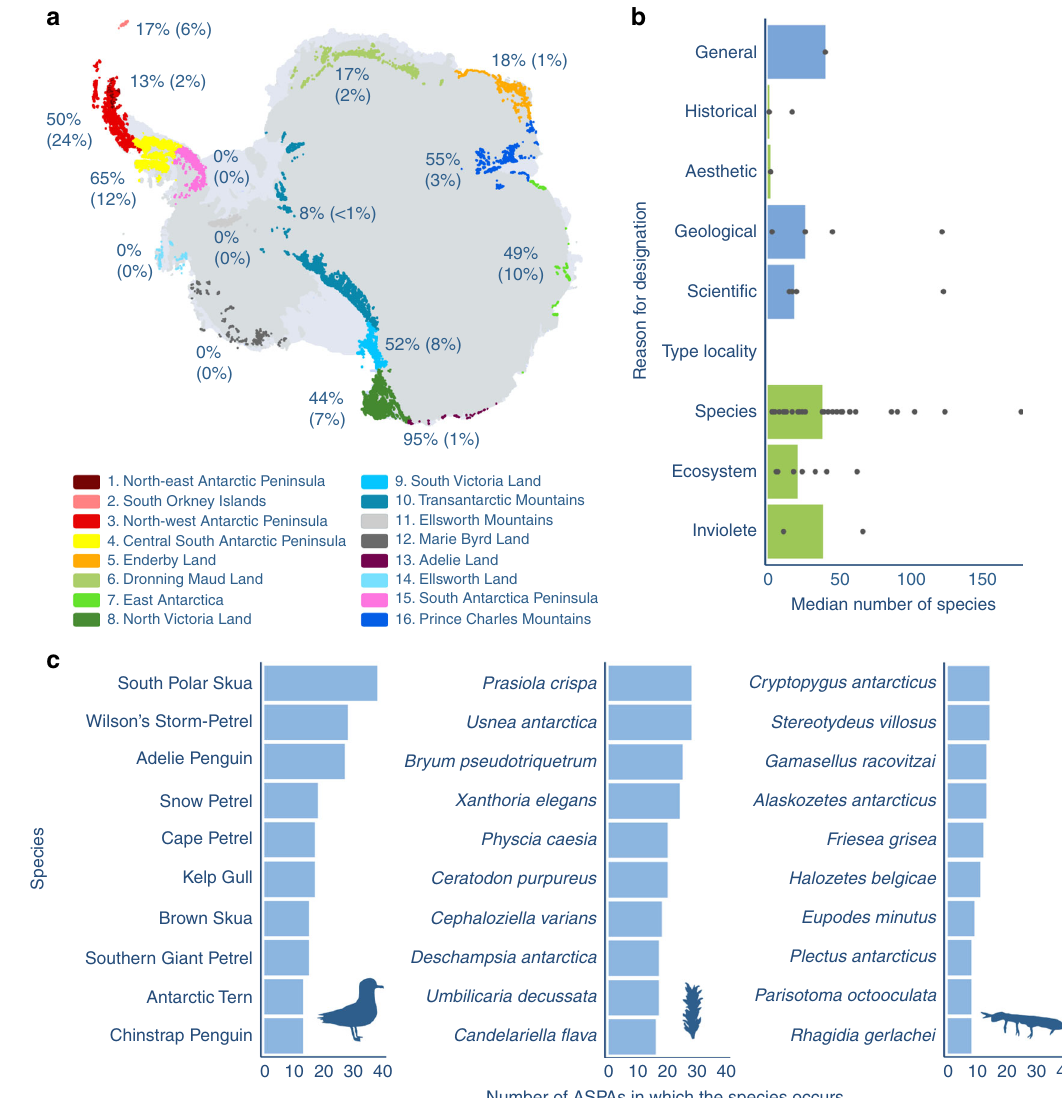
Fig. 1 A snapshot of Antarctic biodiversity protection. a Antarctic ice-free areas are split into 16 Antarctic Conservation Biogeographic Regions 28,31 (ACBRs — denoted by the different colours). The % of species in each ACBR that occur in Antarctic Specially Protected Areas (ASPAs) is shown in bold. The % of all Antarctic species that occur in ASPAs within each ACBR is shown in brackets. b ASPAs are designated for a range of reasons ( y -axis). Bars show median number of species in ASPAs that have been primarily designated to protect biodiversity related values (green) or non-biodiversity values (blue), with points for number of species in ASPAs of each designation overlaid. c The ten vertebrates (left) plants and lichens (middle) and invertebrates (right) that are found in the greatest number of ASPAs. The Antarctic map (1a) uses the coastline layer from the SCAR Antarctic Digital Database (Version 7 www.add.scar.org) and the ACBR layer from the Australian Antarctic Data Centre 38 . Data and code used to create these fi gures are provided as Supplementary Datasets 1,2,3,5 and Supplementary Software